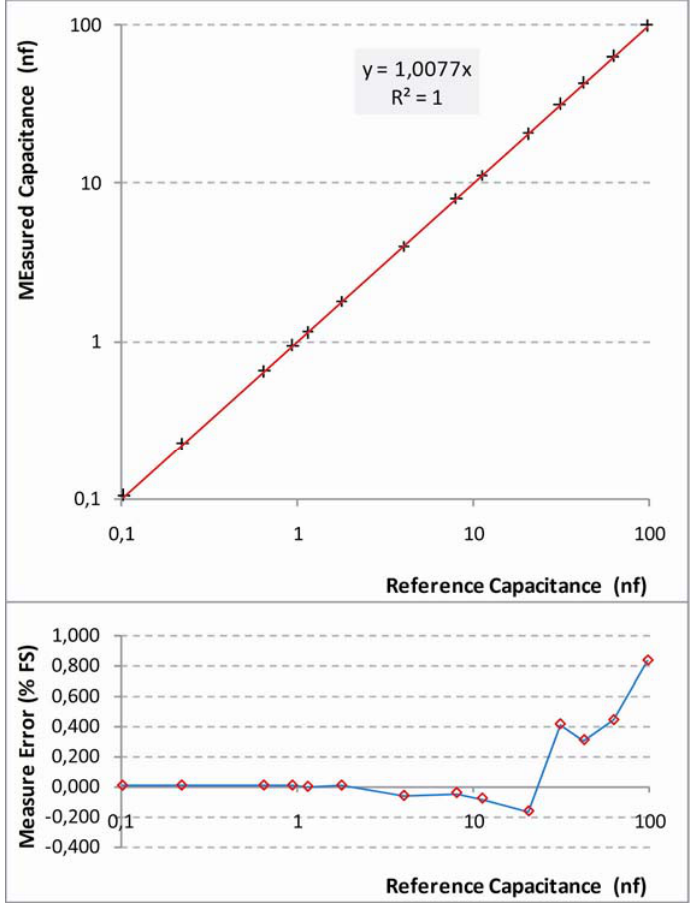
Figure 19. Results of characterization test carried out on UISI Capacitive Sensor configuration. Top graph show the measured capacitance vs. the reference capacitance; Bottom graph shows the corresponding error in Full Scale (FS) percentage.